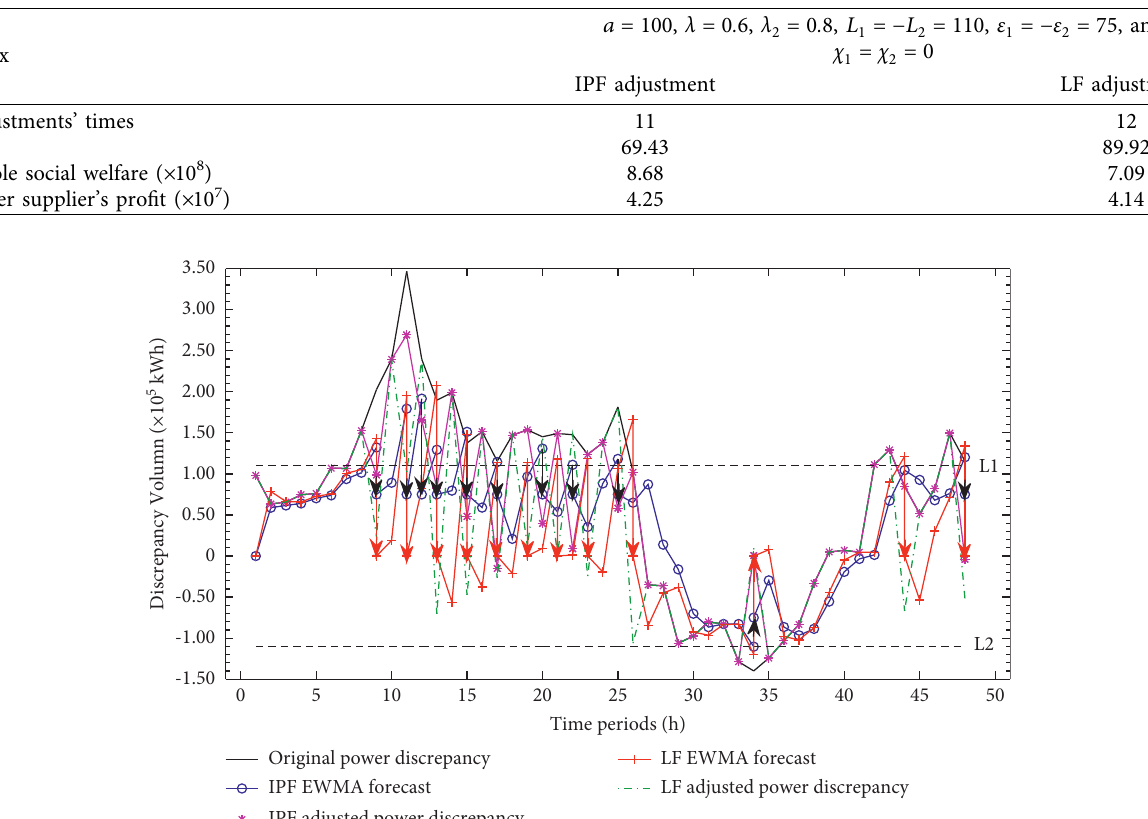
Figure 5: Comparison of IPF adjustments (black arrows mark the IPF adjustment process, red arrows mark the LF adjustment process, black solid lines denote original power discrepancy, blue solid lines with circle markers depict IPF EWMA forecast, and magenta solid lines with asterisks indicate IPF adjusted power discrepancy) and LF adjustments (red solid lines with plus sign markers denote LF EWMA forecast and green dash-dot lines indicate LF adjusted power